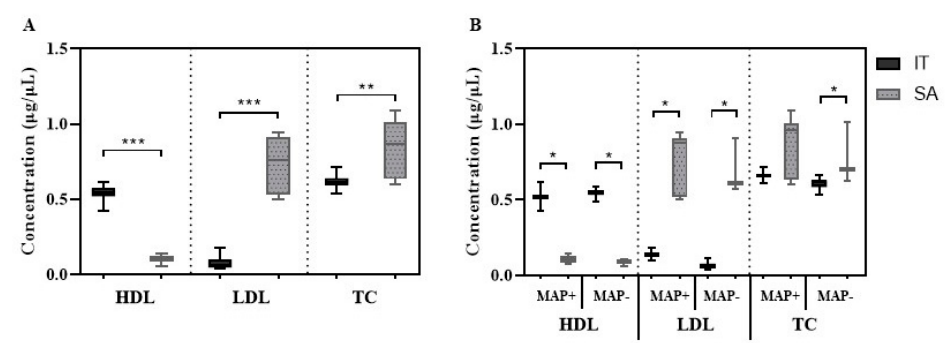
Figure 3. Concentrations of lipoproteins in subjects at risk of T1DM (rT1DM) grouped according to their geographic provenience. ( A ) Comparison between patients enrolled in mainland Italy (IT; n = 10) and Sardinia (SA; n = 12). ( B ) Differences in lipoprotein levels between IT and SA participants grouped according to their serological response to MAP antigens. Mean and standard deviation are indicated for each bar. Upon the analysis of lipoprotein levels in RA, our results showed a statistical difference in HDL concentrations between RA MAP+ and RA MAP- and when comparing RA MAP- with HCs MAP- ( p < 0.0001, Figure 2G). Insignificantly lower HDL concentrations were found among RA MAP+ respect to RA MAP- (Figure 2G). Increased levels of LDL/VLDL were observed in RA MAP+ versus HCs MAP+ ( p = 0.0024, Figure 2H) and in RA MAP- versus HCs MAP- ( p = 0.0052, Figure 2G); however, a comparison between RA MAP+ and RA MAP- showed no difference. Similar results were obtained for TC (Figure 2I), with strikingly lower levels among HCs regardless of anti- MAP Abs status ( p < 0.0001, Figure 2I). 4. Discussion MS, T1DM and RA are among complex autoimmune diseases developing through a multifaceted interplay between genetic determinants, environmental factors and the immune system. Viral and bacterial infections with host’s molecular components play a crucial role in triggering autoimmunity in directed manner or by activating secondary immune responses exacerbating the ongoing autoimmune process. Our previous studies support the hypothesis that MAP may be a contributing agent in the etiology of MS, T1DM and RA through cross-reactivity and molecular mimicry phenomena [5,35–37,42]. Here, we investigated whether humoral responses against MAP correlate with altered lipoprotein profiles typical to these diseases. The outcomes of this study have shown variations in serum cholesterol levels associated with the presence of anti-MAP Abs. Genome-wide association study (GWAS) identified over 100 distinct genetic variants associated with MS predisposition [43] that show a genetic modulation of lipid profiles in disability progression. In addition, recent discoveries showed that other genetic contributors to MS development reside within the ubiquitin-proteasome system that represents an immensely important pathway in protein degradation [44]. Less is known about environmental MS contributors and their link with genetically conferred susceptibility to infections. Recent evidences associate serum lipid levels and lipid-related polymorphisms with disability progression in MS patients [38]. Cholesterol synthesis appears crucial during remyelination of neuroglia [45], while its excess in plasma may aggravate neuronal cell damage [46], thus conflicting results have been obtained for lipoprotein concentrations and degree of disability in this disease [25,41,47]. Our results indicated higher levels of serum lipoprotein levels in MS patients, showing lower HDL concentrations among MAP+ subjects which correlated with higher EDSS. It is possible that lipid-related SNPs inducie imbalance of cholesterol, thereby favoring mycobacterial survival in macrophages. This